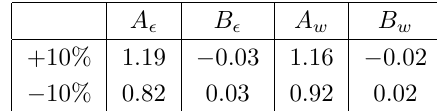
Table 1 . Fitted values for the parameterisation of the event weight correction with a variation of (cid:6) 10% from the nominal value of the OM photon detection e(cid:14)ciency and water absorption